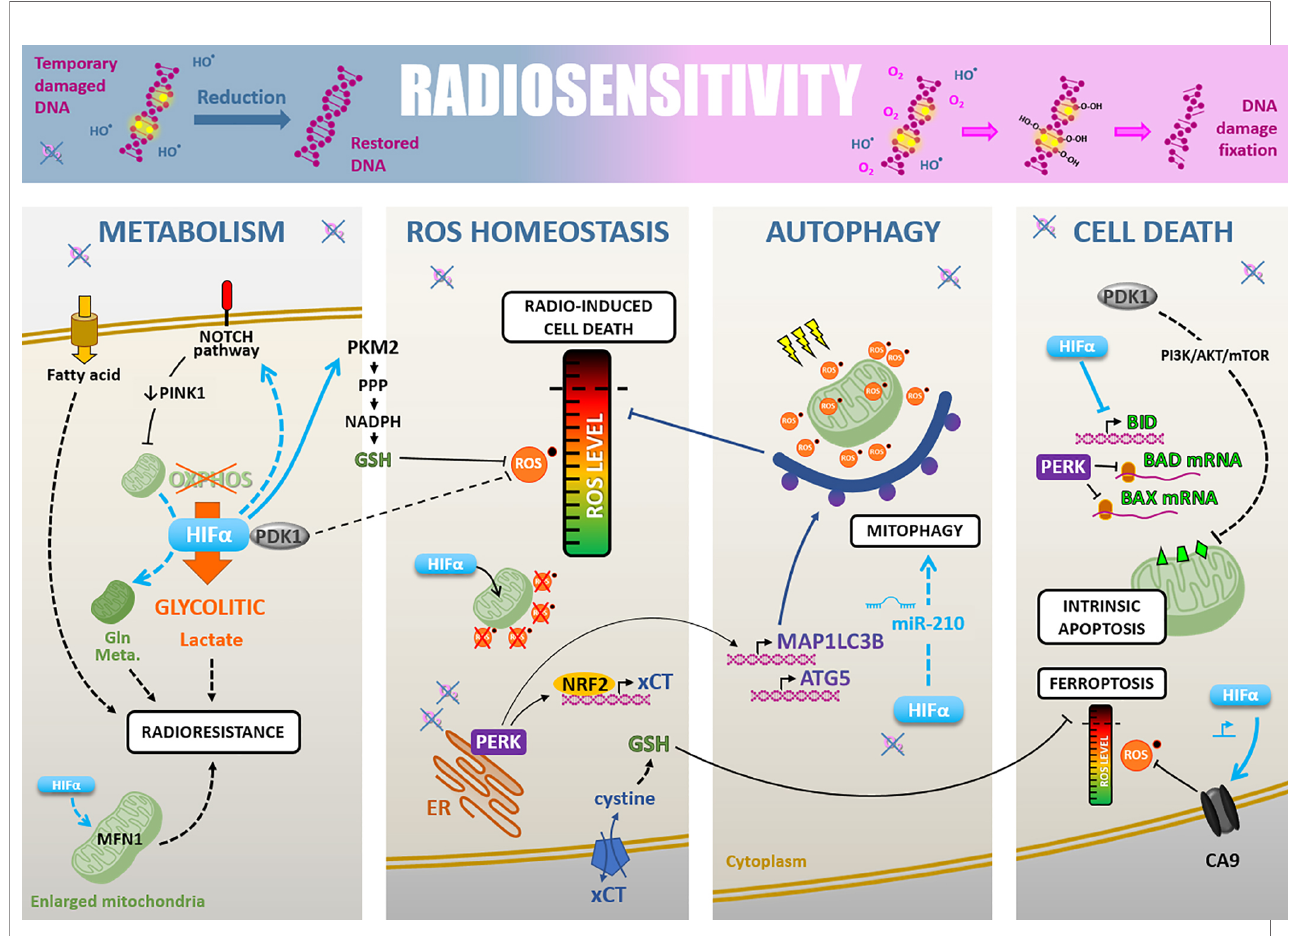
FIGURE 3 | Radiosensitivity. Cell-intrinsic radiosensitivity can be linked to the fi xation of radiation-induced DNA damages in the presence of oxygen, whereas a hypoxic environment favors the reduction of DNA radicals and return to a restored DNA (upper part). Hypoxia also impacts radiosensitivity through different cellular adaptions. i) The cell metabolism modi fi cations, mainly PDK1-mediated glycolytic switch leading to lactate production, but also fatty acid uptake, NOTCH-dependent mitochondrial glutamine metabolism increase, and mitochondria fusion. ii) The ROS homeostasis is maintained under the critical level by PDK1 increase, HIF a - mediated GSH regeneration, HIF a translocation to mitochondria leading to their ROS production decrease, and PERK-mediated xCT expression promoting GSH synthesis. iii) Induction of HIF a - and PERK-mediated autophagy of ROS-productive damaged mitochondria. iiii) The cell death regulation through a HIF a -, PDK1- and PERK-mediated inhibition of antiapoptosis modulators BID, BAD, and BAX, and a HIF a -induced CA9 expression decreasing ROS level and inhibiting